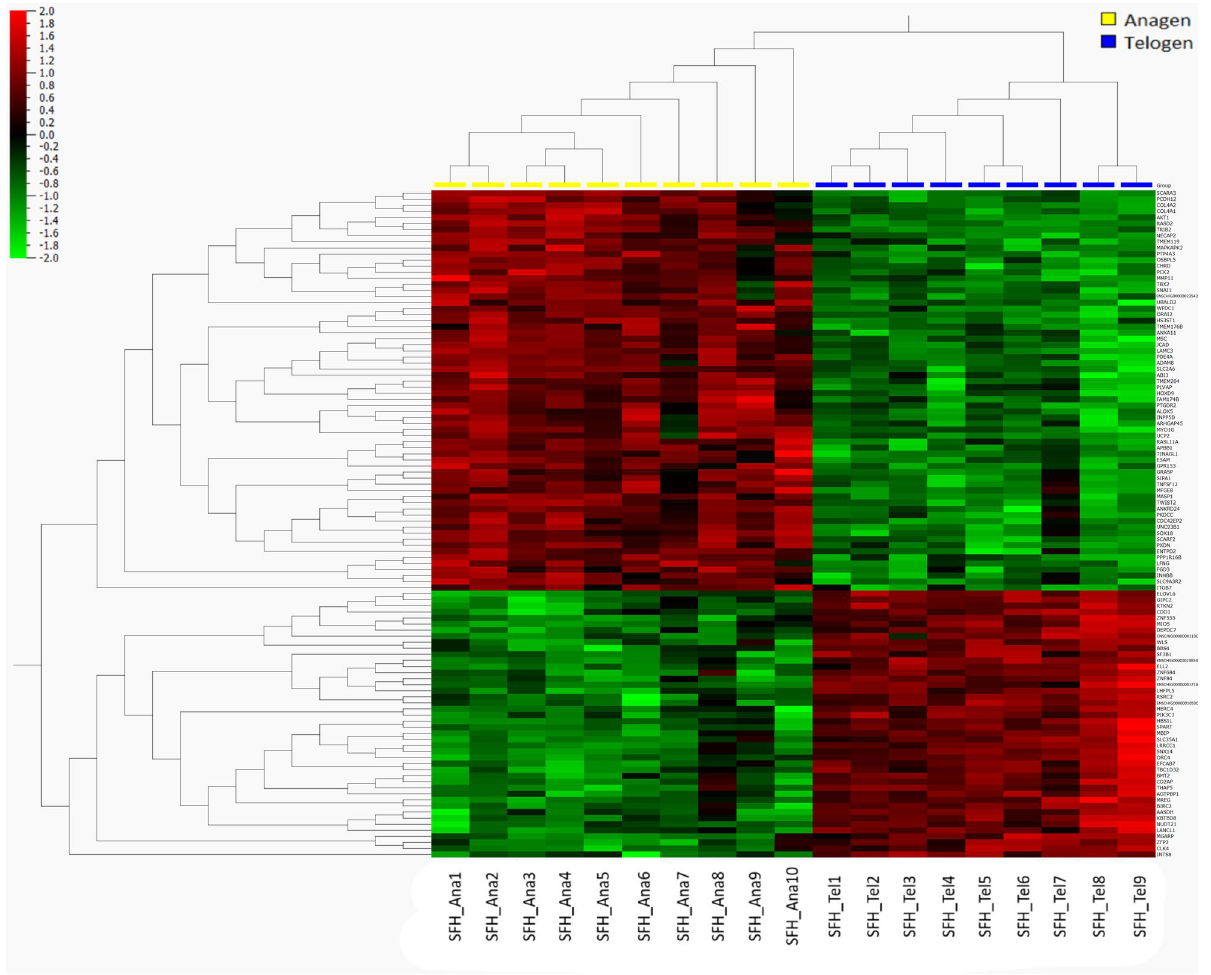
Figure 1. Hierarchical clustering and heatmap of top DEGs between two contrast groups. Columns indicate individual samples, rows represent each differentially expressed gene, and the color scale represents the relative expression level of the differentially expressed